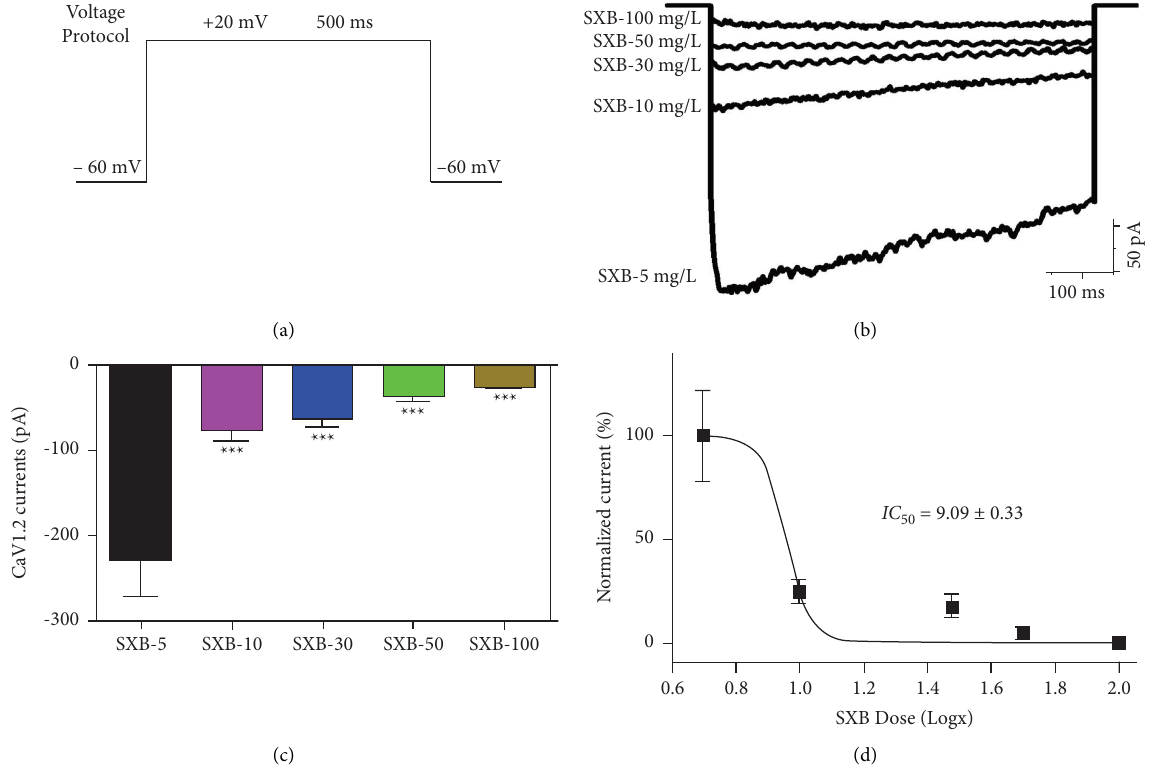
Figure 4: SXB dose-dependently inhibits the hCaV1.2 currents. (a) Voltage protocol was listed in detail in results 3.3. (b) Typical hCaV1.2 currents were represented in the 5 SXB groups (5.10, 30, 50, and 100mg/L). Concentration-response bar graph (c) and curve (d) were displayed in 5 SXB groups and IC50 was listed. ∗∗∗ P < 0 . 01, vs. the SXB − 5mg/L